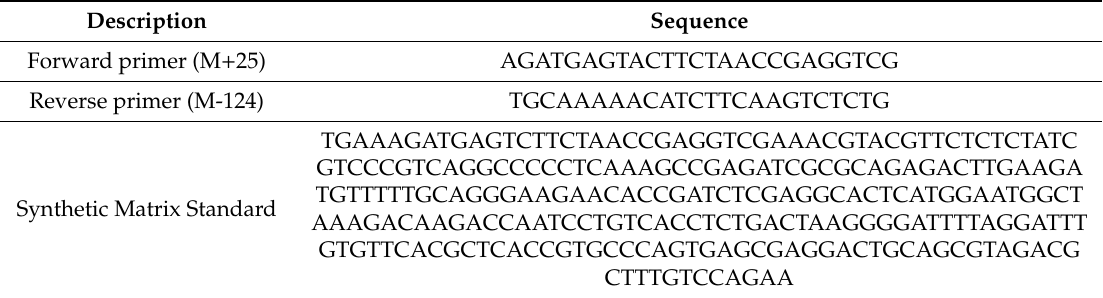
Table 3. Primers and synthetic standard used for screening the type A matrix gene by